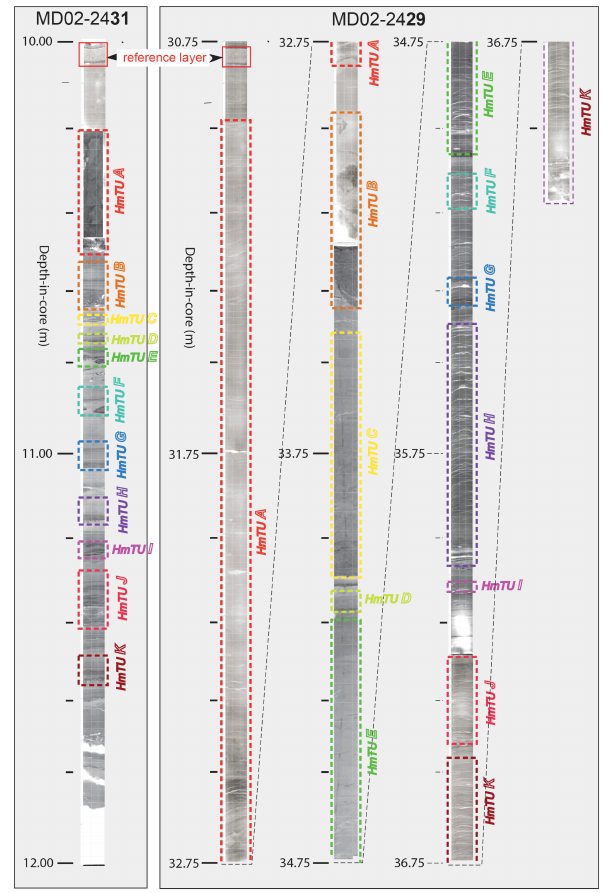
Figure 5. X-ray close up of two synchronous portions of cores MD01-2429 and MD01-2431, displaying individually correlated sedimentary events (homogenite + turbidite).